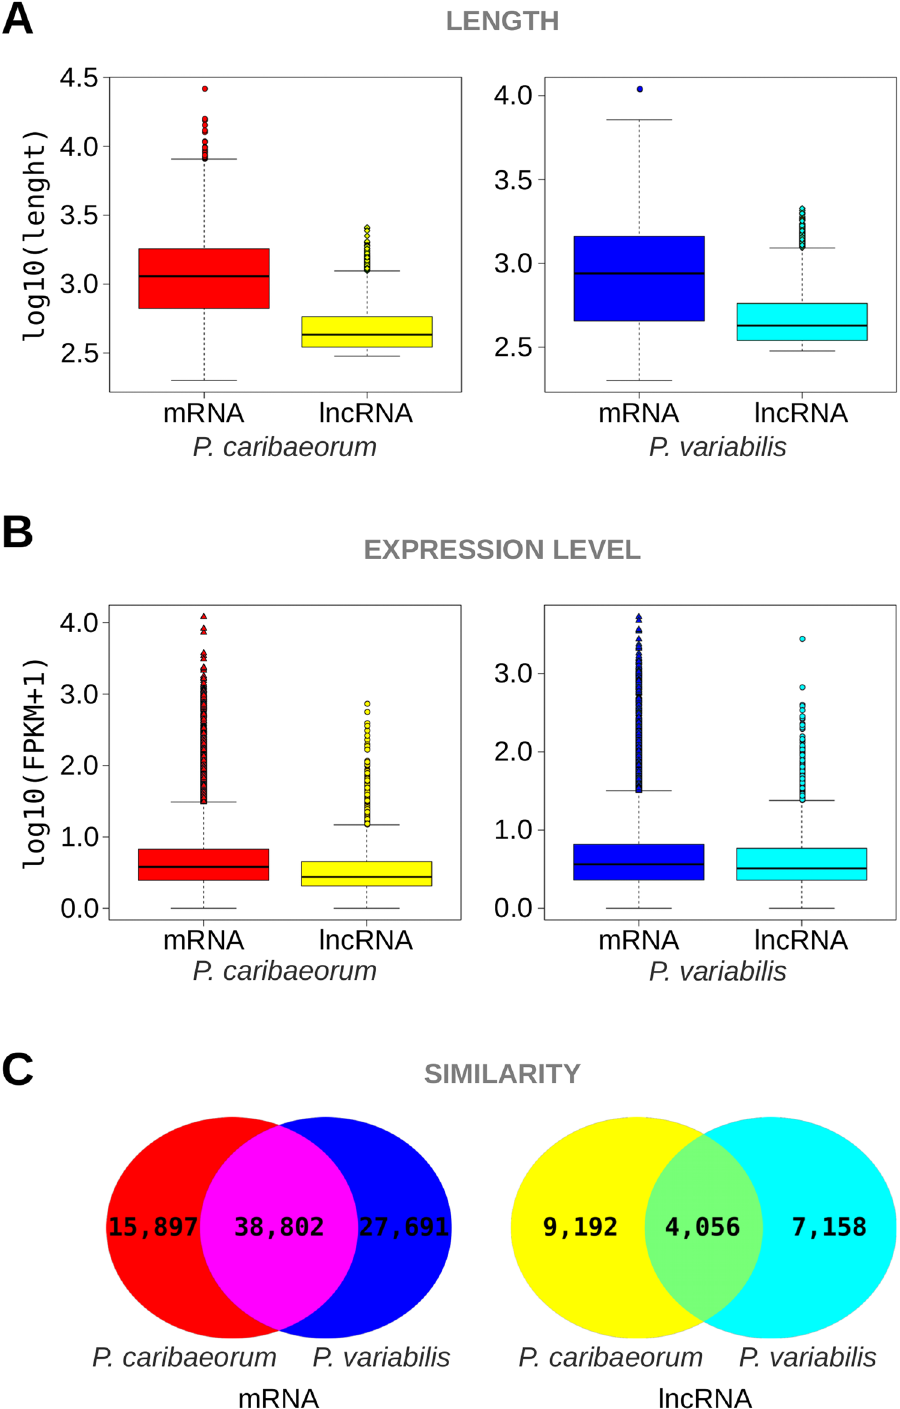
Figure 3. General characteristics of mRNAs and lncRNAs in Protopalythoa variabilis and Palythoa caribaeorum . ( A ) Distribution of transcript length by log 10 (Length) in mRNAs and lncRNAs in Protopalythoa variabilis and Palythoa caribaeorum . ( B ) Expression level indicated by log 10 (FPKM + 1) in mRNAs and lncRNAs in Protopalythoa variabilis and Palythoa caribaeorum . ( C ) Comparison of mRNAs and lncRNAs from P . variabilis and P . caribaeorum